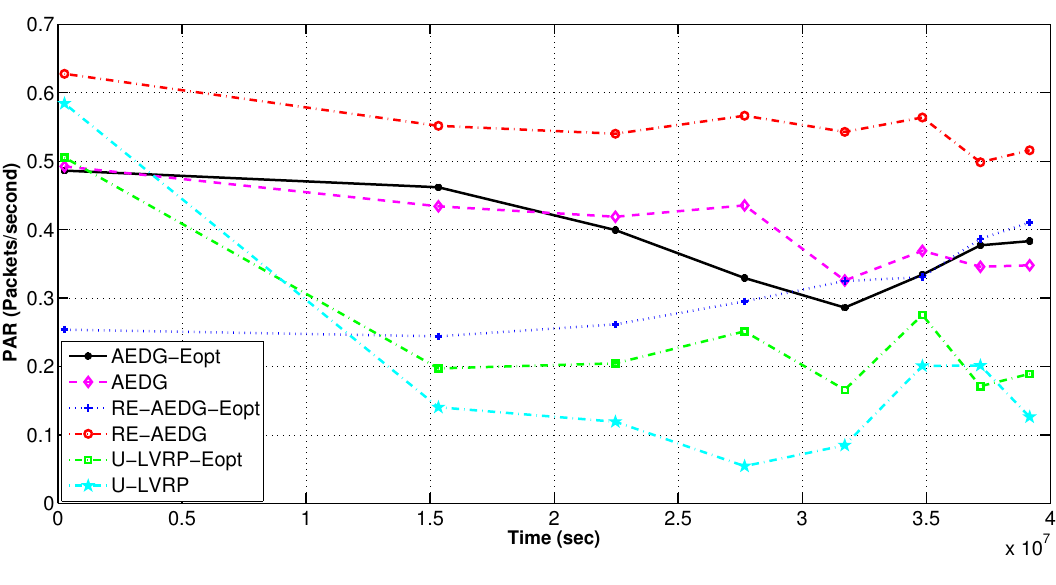
Figure 14. PAR of networks in energy optimized and non optimized protocols.